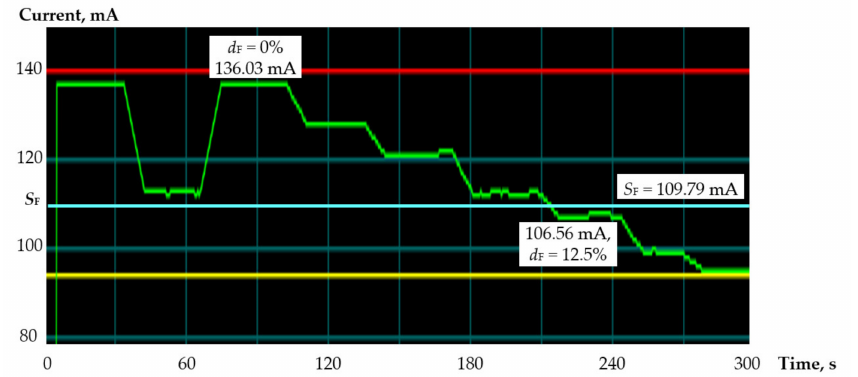
Figure 8. Current consumption charts for FIR